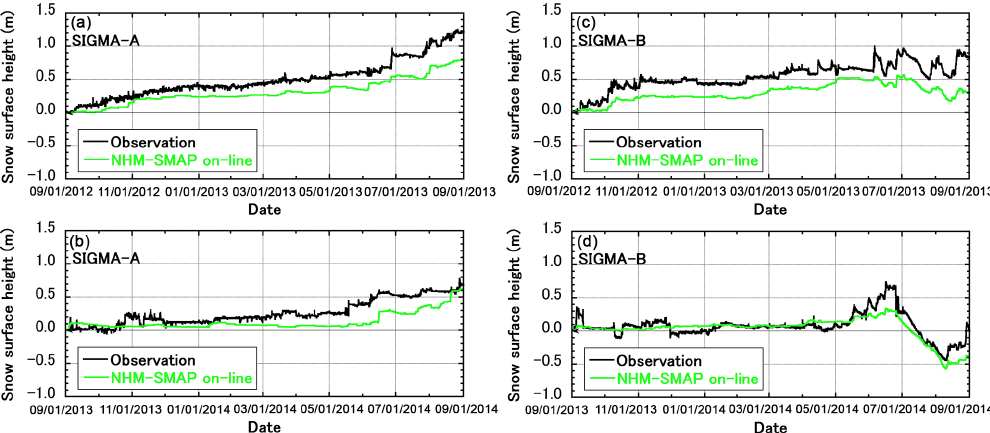
Figure 6. Time series of observed and simulated hourly snow surface height with respect to 1 September. (a) SIGMA-A, 2012–2013;